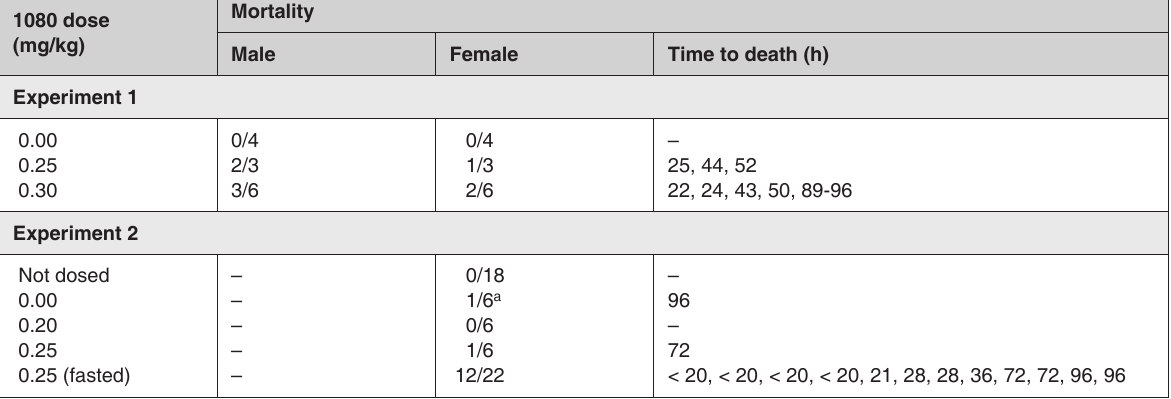
TABLE 1 Mortality of sheep following exposure to sodium monofluoroacetate (1080) 1080 dose (mg/kg)